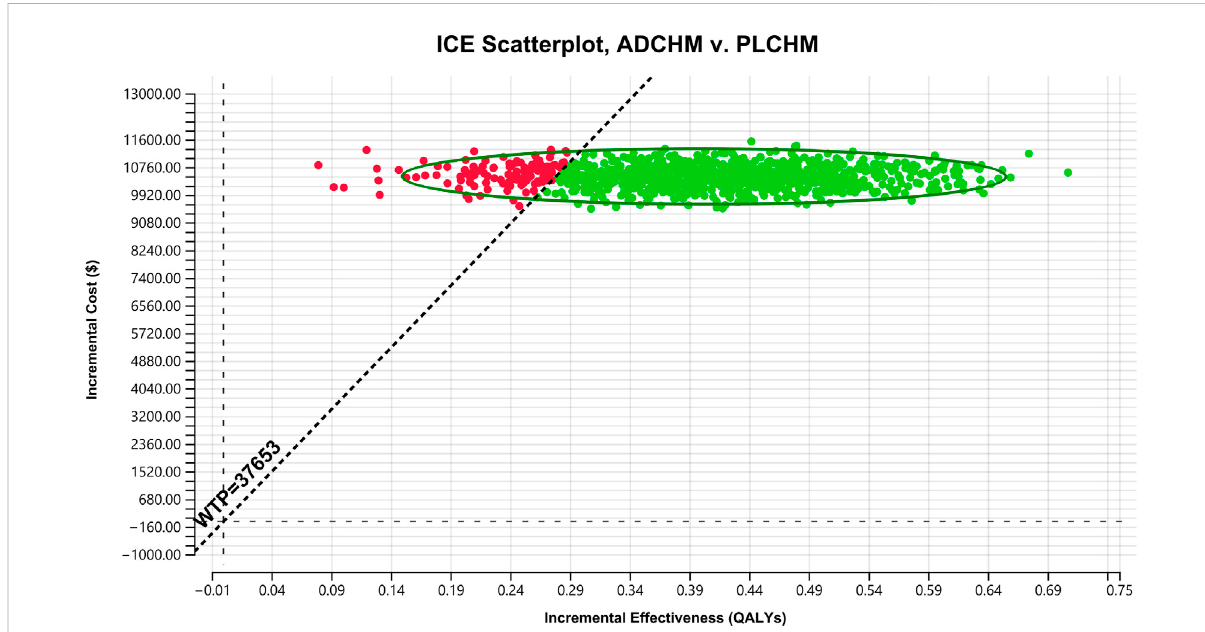
FIGURE 3 A probabilistic scatter plot of the ICER between the ADCHM group and the PLCHM group. Each point means the ICER for 1 simulation. Ellipses areused toindicate 95% con fi denceintervals. Pointsthat liebelowtheICERthreshold represent cost-effectivesimulations.ADCHM:adebrelimabin combination with chemotherapy (etoposide-carboplatin); PLCHM: placebo plus chemotherapy (etoposide-carboplatin); QALYs, quality-adjusted life years; ICER: incremental cost-effectiveness ratio; WTP: willingness-to-pay.